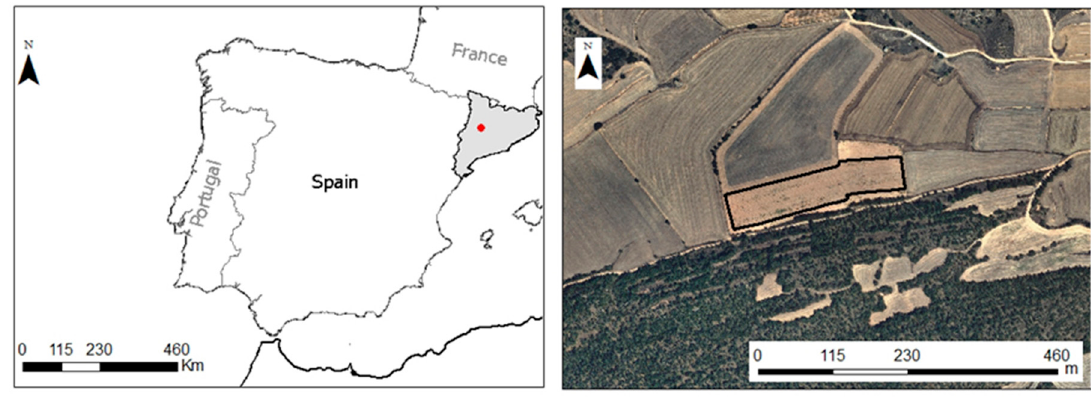
Figure 1. Geographical location of the experimental field in Oliola (Lleida), in the northeast part of Spain.